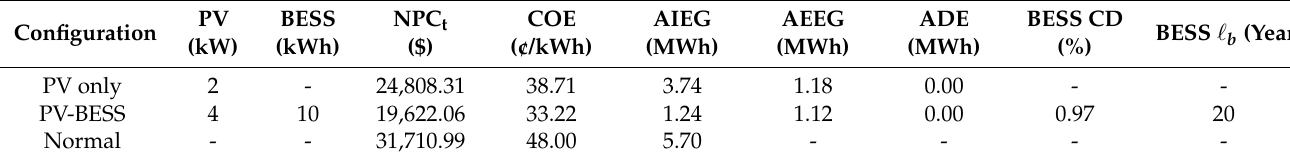
Table 8. Optimal results for both system configurations with Option 3 (Flat–TOU).